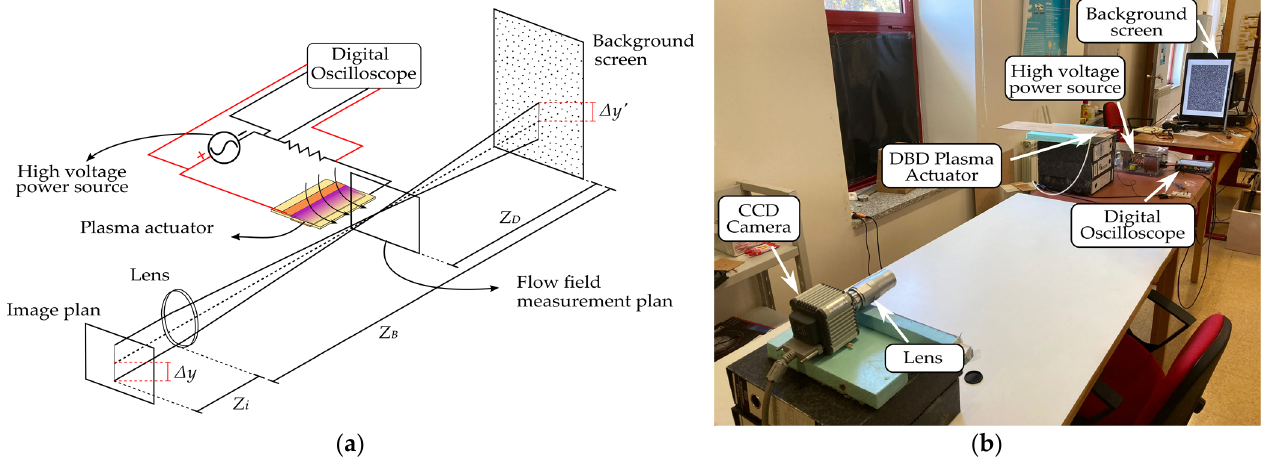
Figure 1. Experimental setup ( a ) schematic of the implemented BOS method; ( b ) photo of the equipment used.